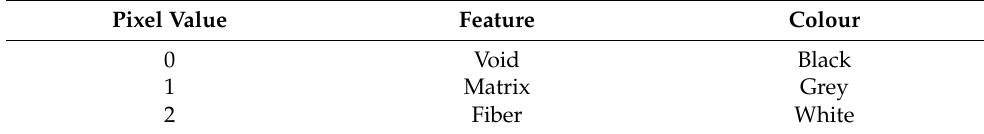
Table 5. Pixel values for each feature in the extracted ground truths.